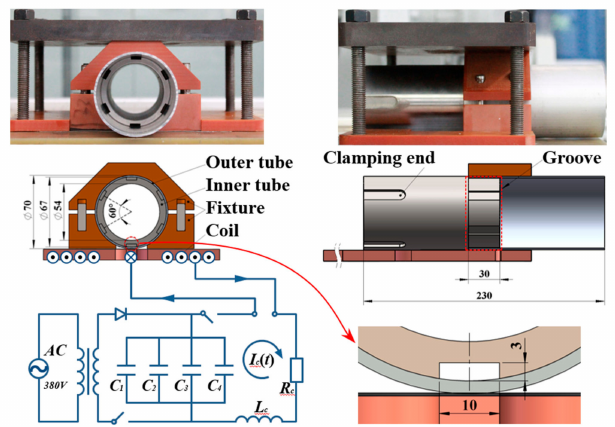
Figure 2. Setup for electromagnetic crimping and the size of specimens (dimensions in